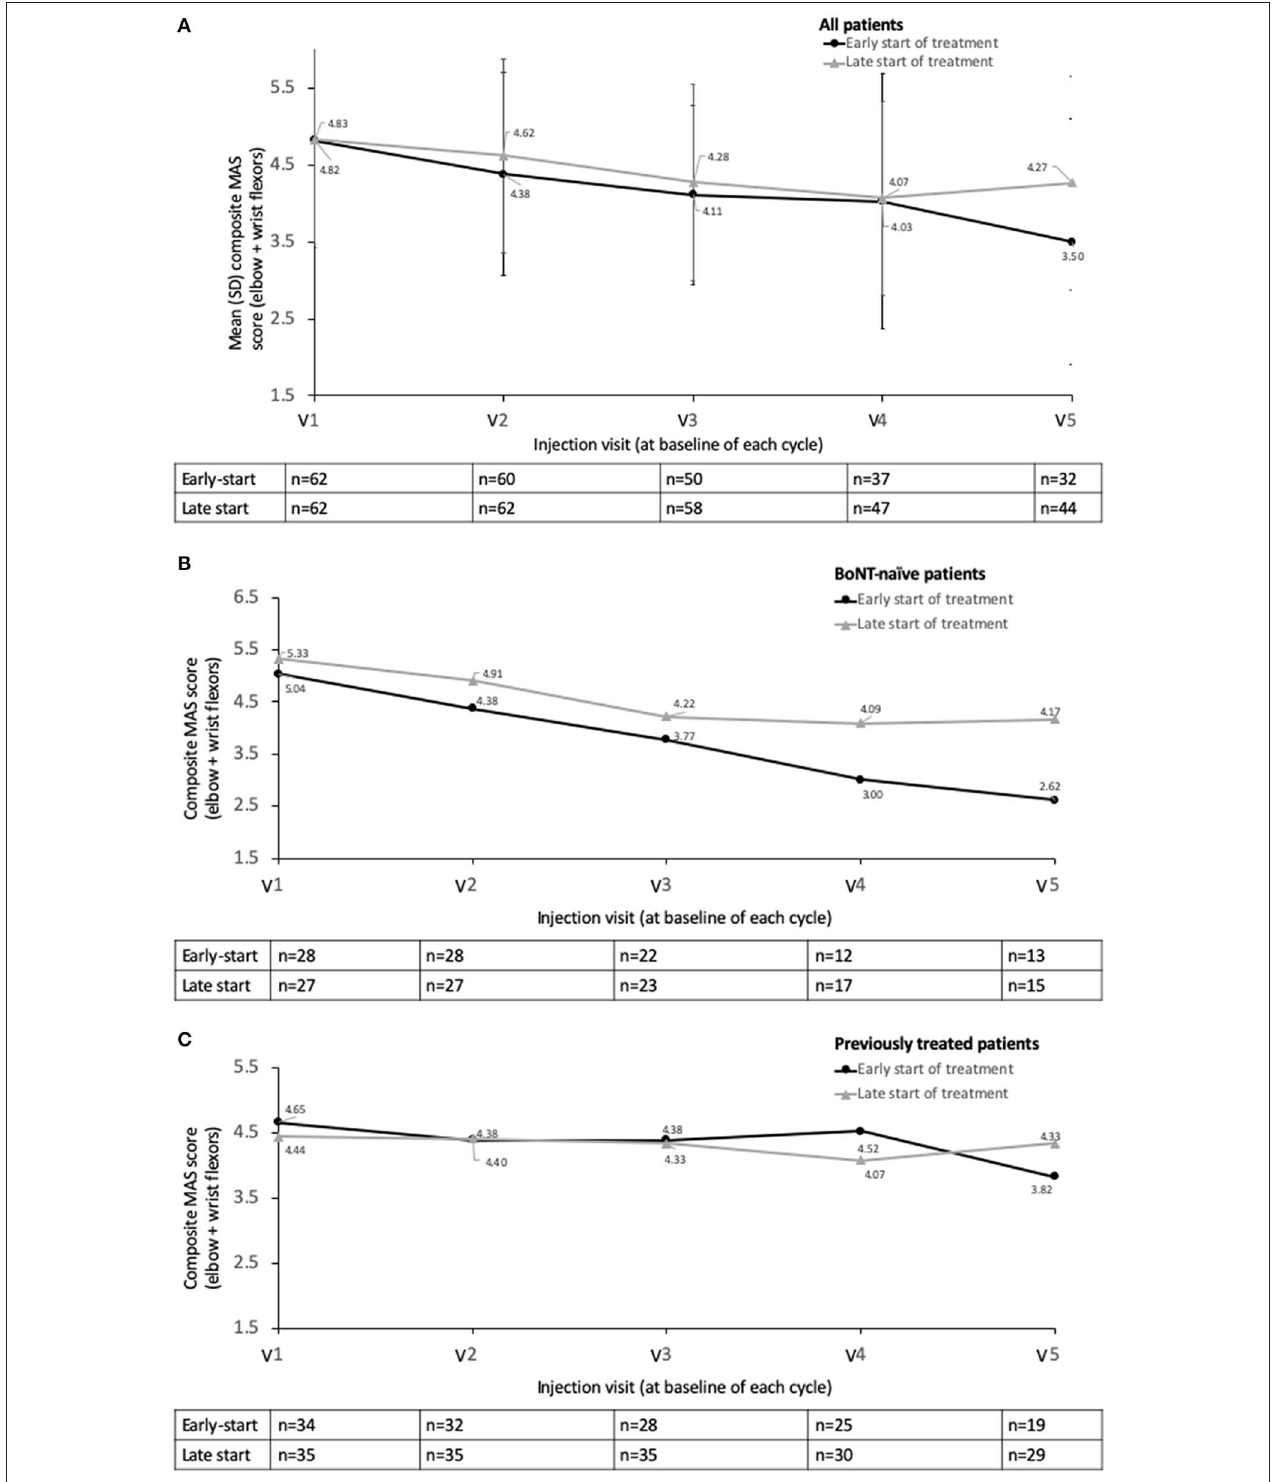
FIGURE 2 | Descriptive statistics for MAS EWF by study visit, early-start vs. delayed start subgroups (A) overall population, (B) BoNT-naïve population, and (C) previously treated population. Study visits were at end of treatment cycle.